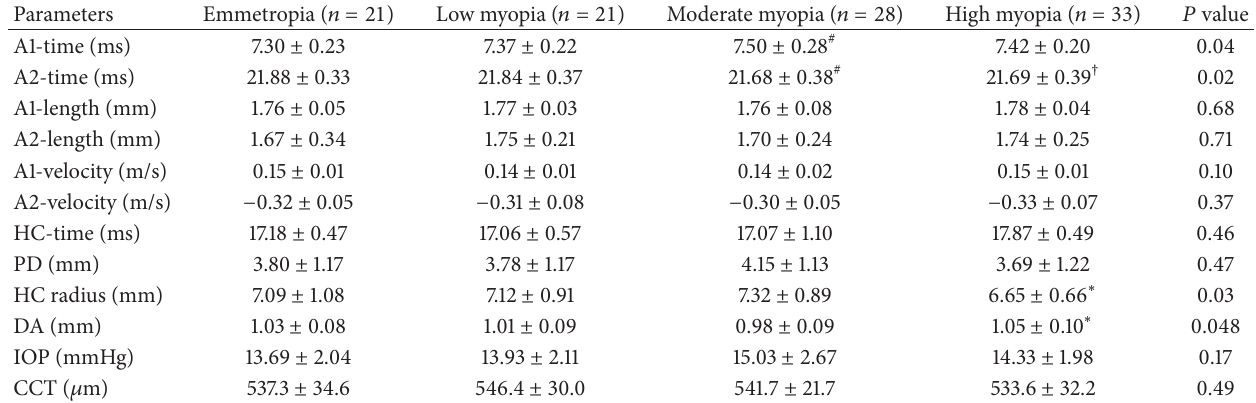
Table 2: All the parameters obtained by CorVis ST for the 4 groups, mean ± SD.